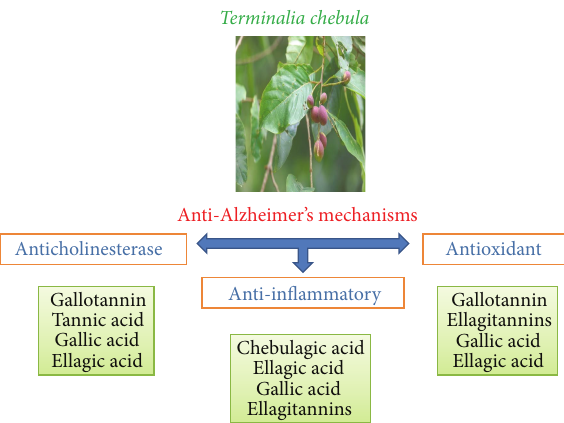
Figure 2: Anticholinesterase, anti-inflammatory, and antioxidant properties of T. chebula relevant to anti-Alzheimer’s